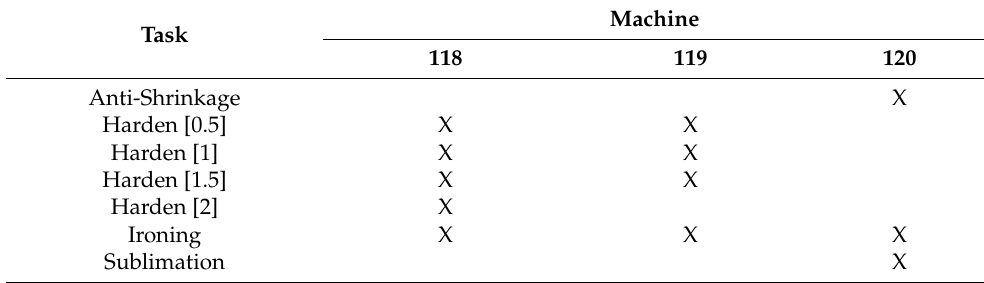
Table 1. Tasks that each machine